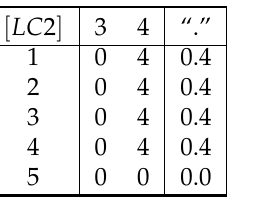
Figure 21. [ LP 1 ] on Figure 1.